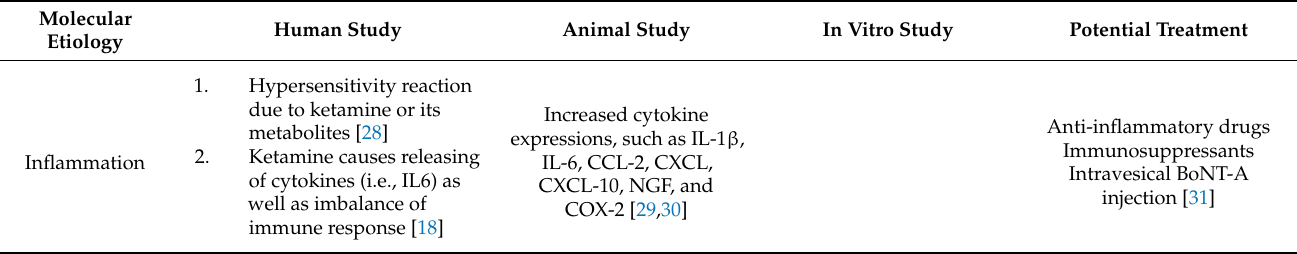
Table 1. Possible molecular etiology and potential targeted treatment of KC based on human, animal, and in vitro